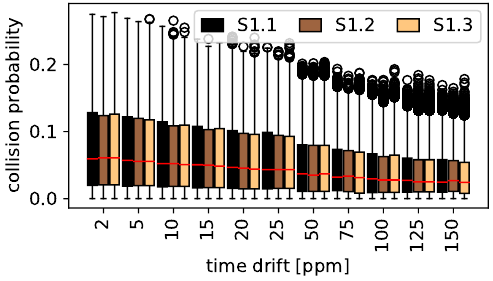
Figure 7. Scheduled and random access: clock drift study.